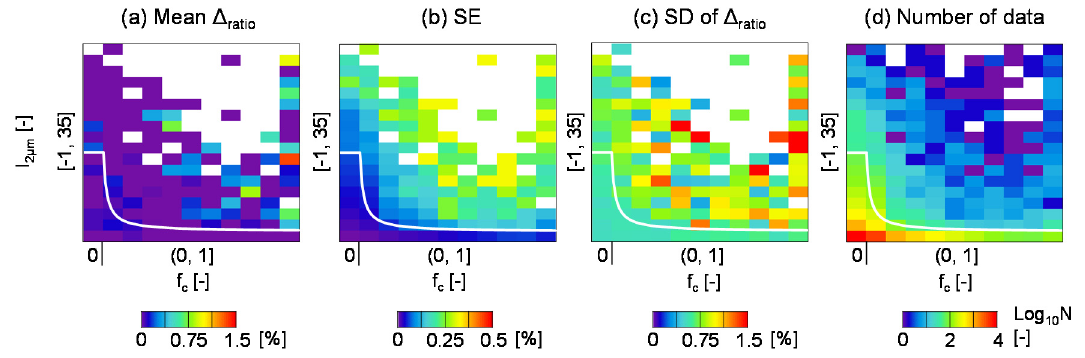
Figure 8. Similar to Figure 2, but for the bias-corrected ratio component: ( a ) mean relative difference in the ratio component between GOSAT and TCCON ( Δ ratio ); ( b ) standard error (SE); ( c ) standard deviation (SD) of Δ ratio ; ( d ) number of data points. The white line indicates the cloud screening criterion.